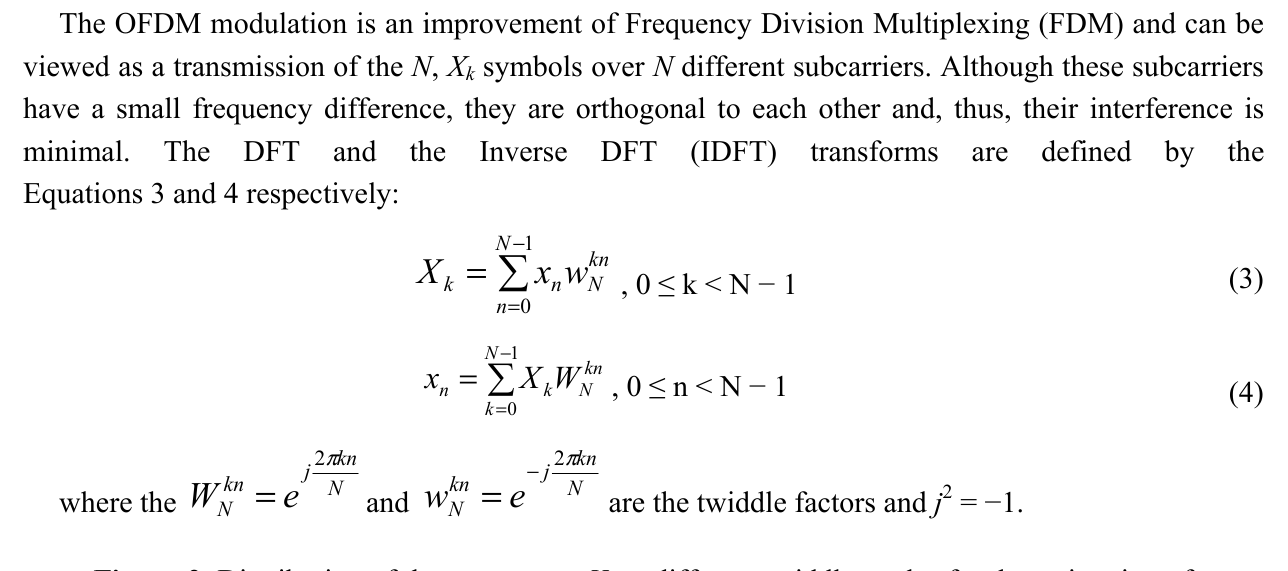
to different twiddle angles for the estimation of k